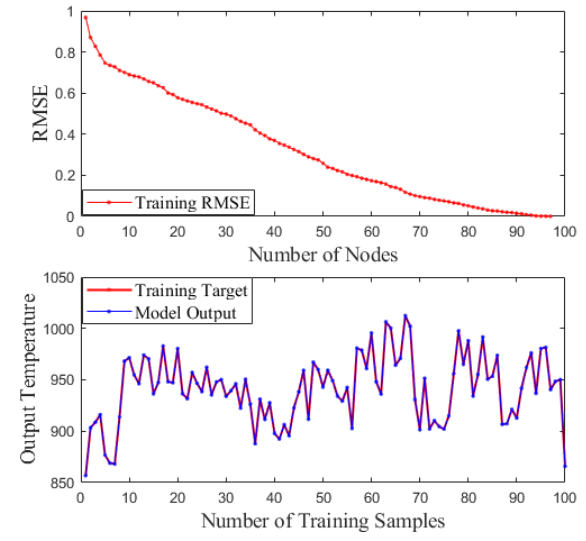
Figure 6. Training situation of SCN